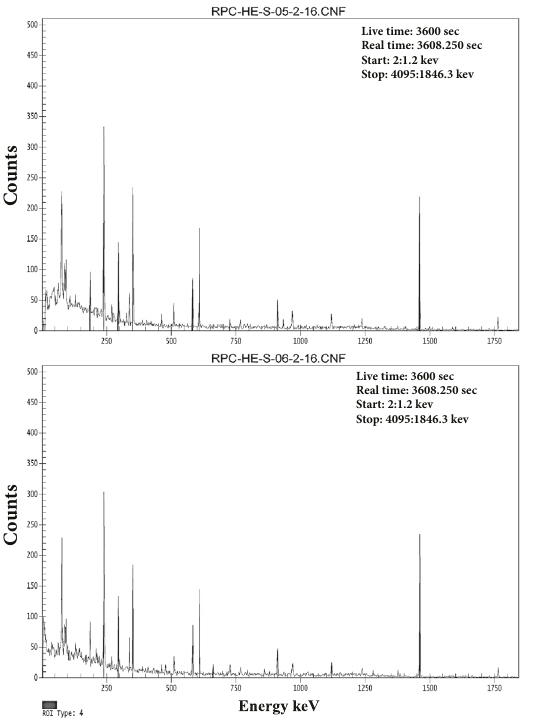
Figure 5: Same as Figure 3 for samples 5 and